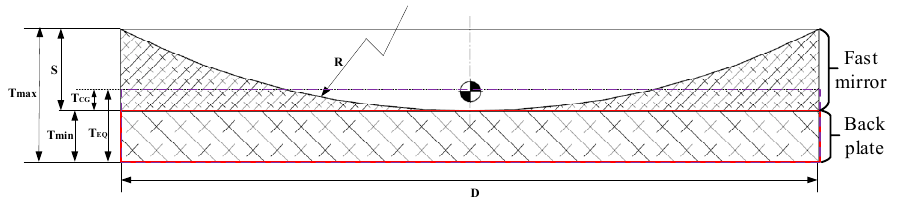
Figure 3. Equivalence of high-steepness circular mirror plate.